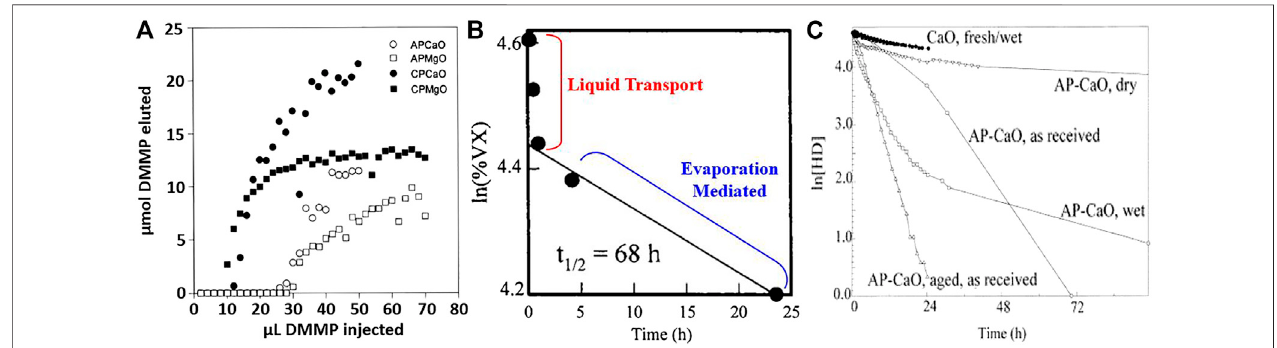
FIGURE 4 | (A) Comparison of destructive adsorption of DMMP over aerogel-prepared (AP) and conventionally prepared (CP) nanometric oxides. Adapted from Klabunde et al. (1996) with permission from the American Chemical Society. (B) Reaction pro fi le of VX on AP-MgO. Adapted from Wagner et al. (1999) with permission fromtheAmericanChemicalSociety. (C) Reactionpro fi leforHDonCaOandAP-CaOundervariousconditions.AdaptedfromWagneretal.(2001)withpermissionfrom the American Chemical Society.